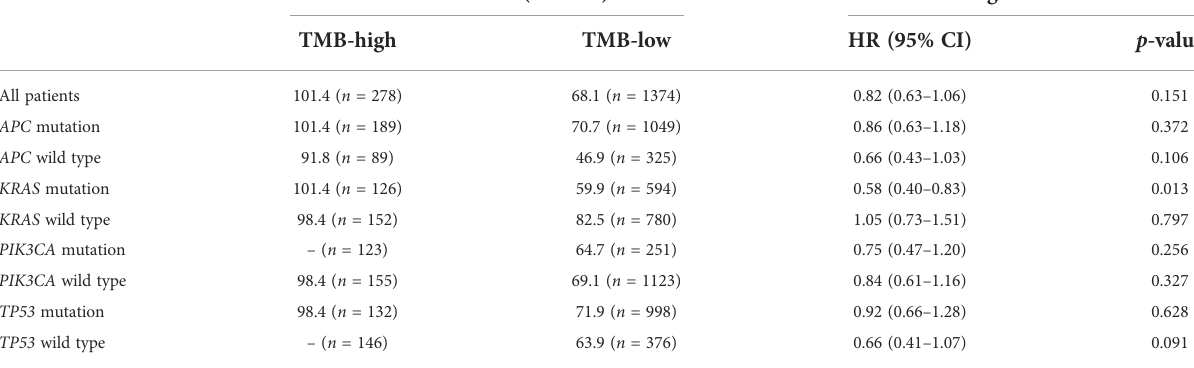
TABLE 3 Correlation between TMB and overall survival.